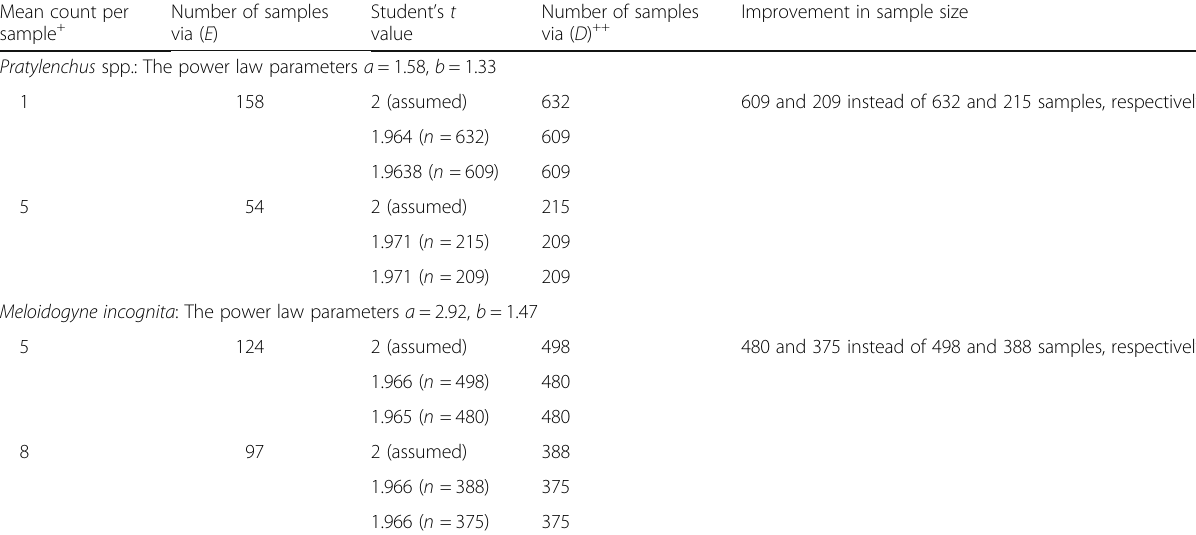
Table 1 Iteration-based improvement in minimum number of nematode samples needed to achieve a 10% level of reliability as defined in terms of standard error to mean ratio ( E ) or confidence interval half-width to mean ratio ( D ) with